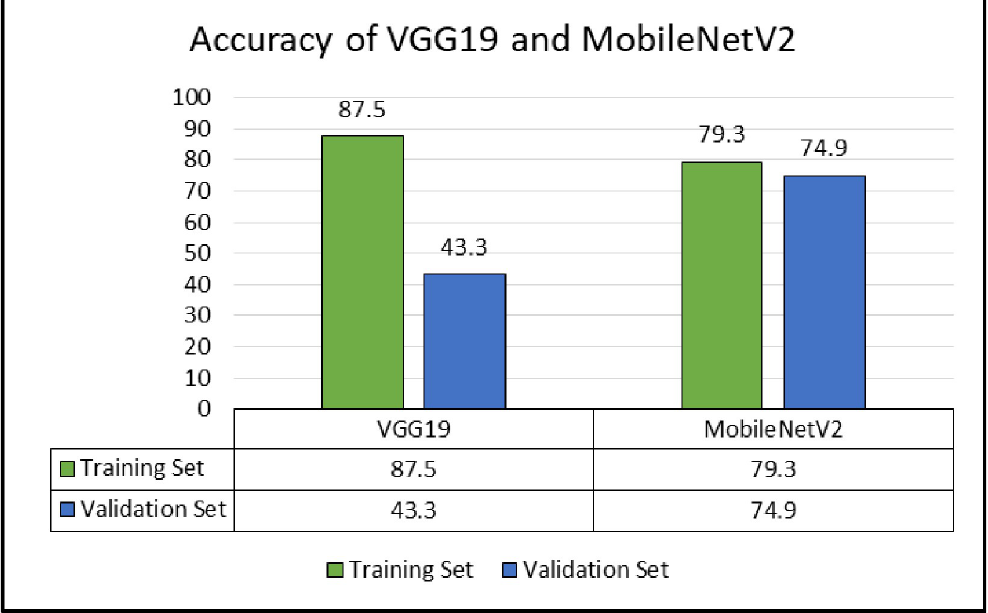
Fig 11. Training and validation accuracies of VGG19 and MobileNetV2.